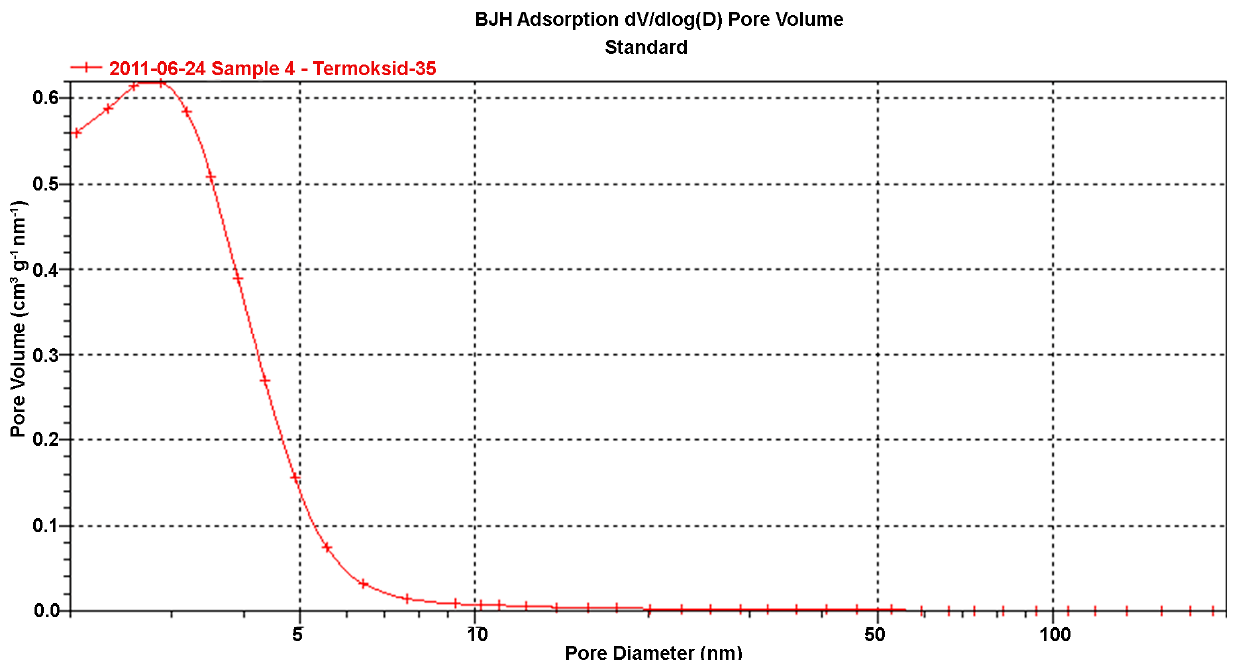
Figure 8. BJH pore size distribution of Termoksid-35 sorbent. X -axis is the pore diameter, nm; Y -axis is the volume of pores of a specific diameter, cm 3 g −1 of the sorbent.